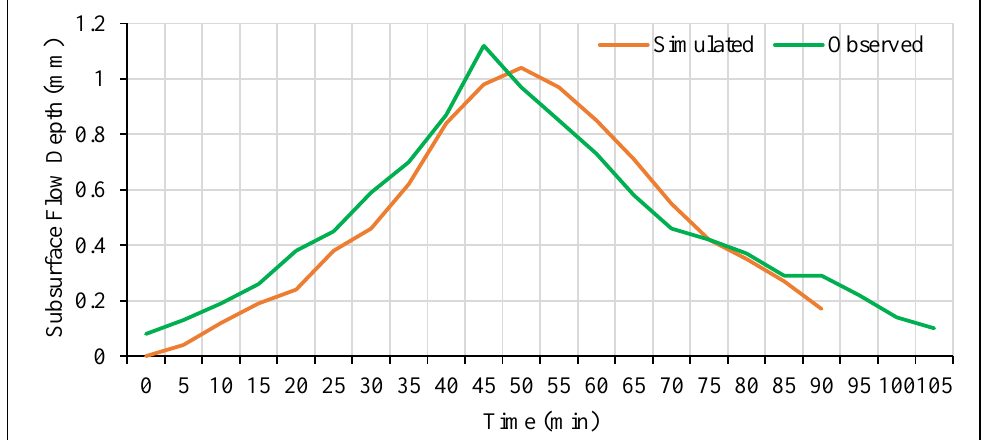
Figure 11. Subsurface flow hydrograph for rainfall intensity of 100 mm/h for 30 min.